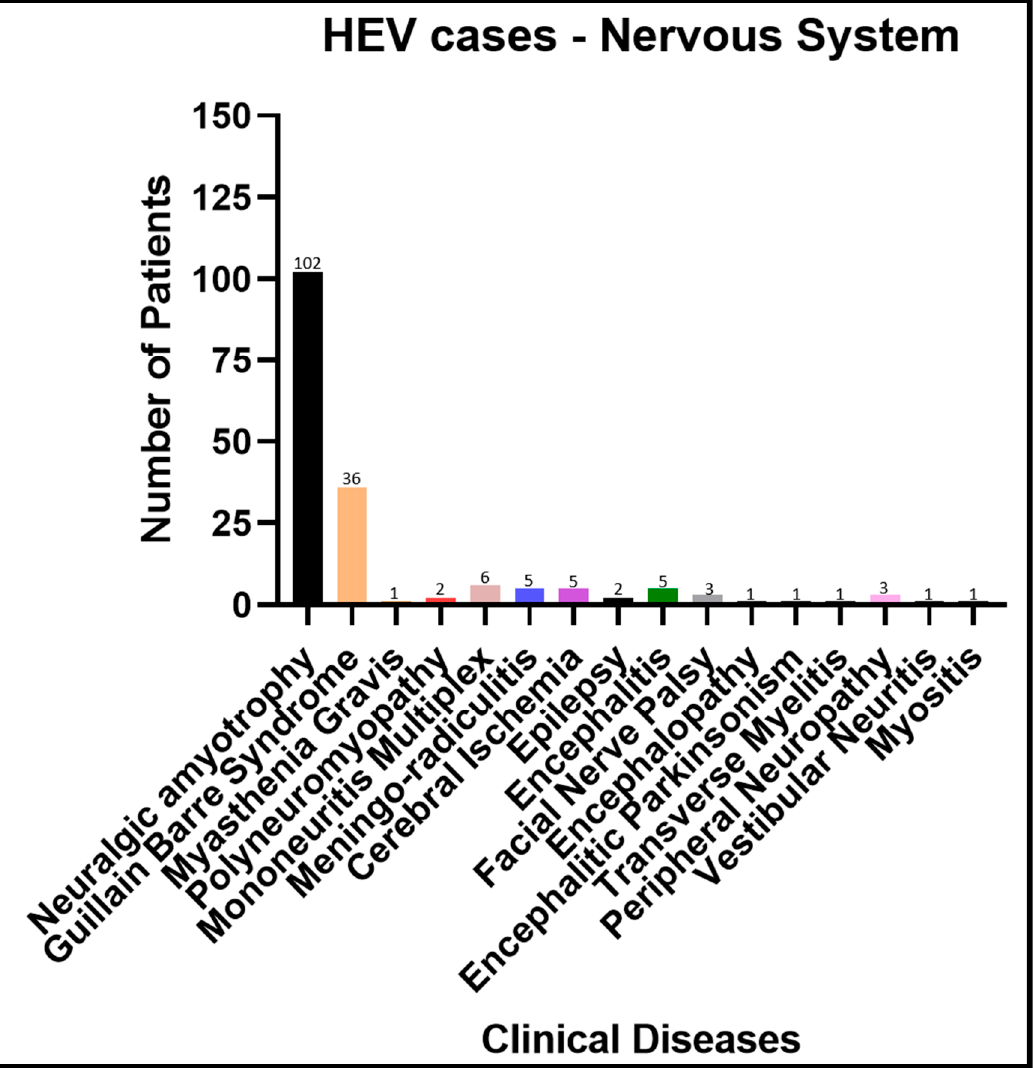
Figure 1. Summary of neurological and musculoskeletal clinical disorders presented in relation to HEV infection. The numbers are extracted from case reports, retrospective studies, case–control studies, case series, and cross-sectional studies. Every disorder and their references are listed in Table 1.